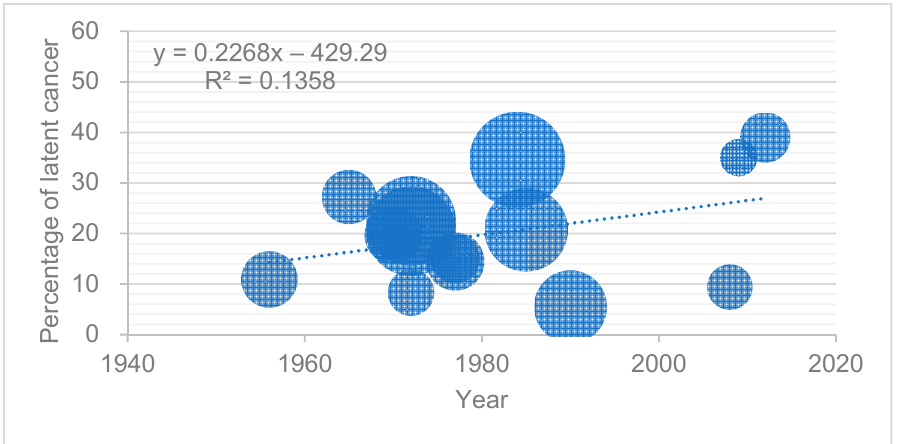
Figure 2. Prevalence of latent PC in the studies on Asian populations. Prevalence of latent PC in studies of Asian countries published after 1950 by year of publication. The size of each point was proportional to the number of men in the study.